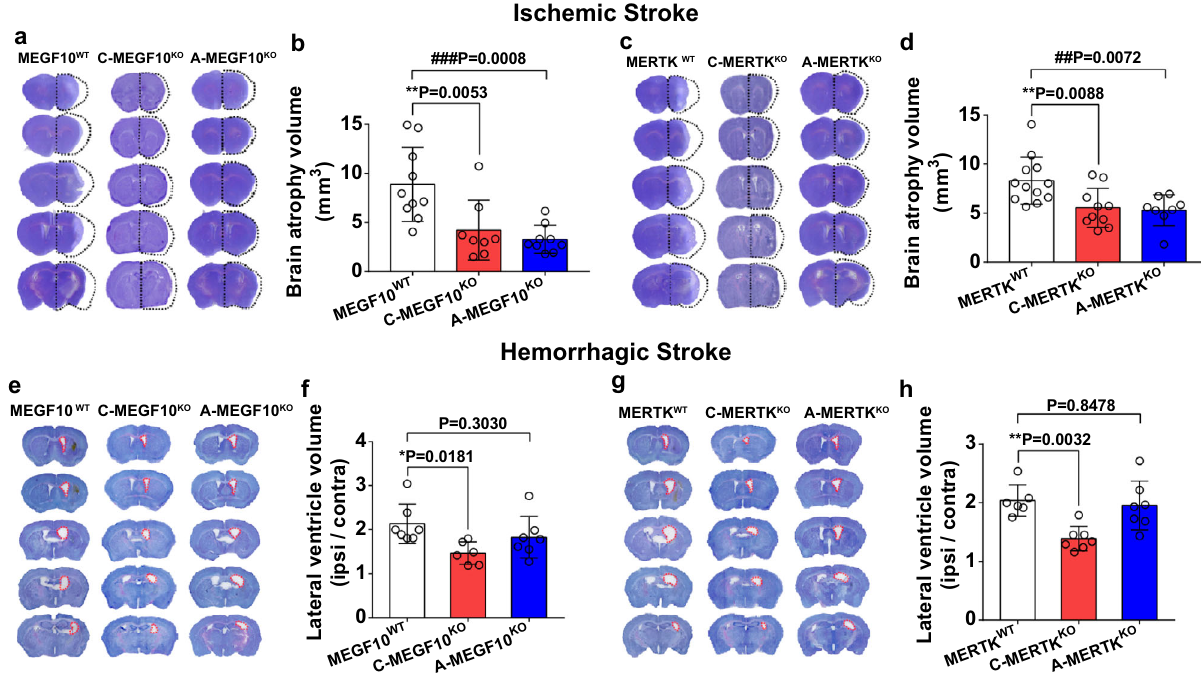
Fig. 8 Conditional MEGF10 or MERTK knockout in microglia/macrophages or astrocytes differentially affected brain impairment in mice after ischemic and hemorrhagic stroke. a – d Cresyl violet-stained brain sections and quanti fi cation of atrophy volume of MEGF10 WT , C-MEGF10 KO , A-MEGF10 KO , MERTK WT , C-MERTK KO , and A-MERTK KO mice at 14 days after ischemic stroke. Black dashed lines indicate brain atrophy. N = 10, 8, 9 mice ( b ) and 12, 10, 8 mice ( d ) (from left to right). e – h Cresyl violet-stained brain sections and quanti fi cation of lateral ventricle volume of hemorrhagic mice. Red dashed lines indicate lateral ventricle of ipsilateral brain. N = 7, 6, 7 mice ( f ) and 6, 7, 7 mice ( h ) (from left to right). One-way ANOVA followed by Dunnett ’ s test. Data are mean ±